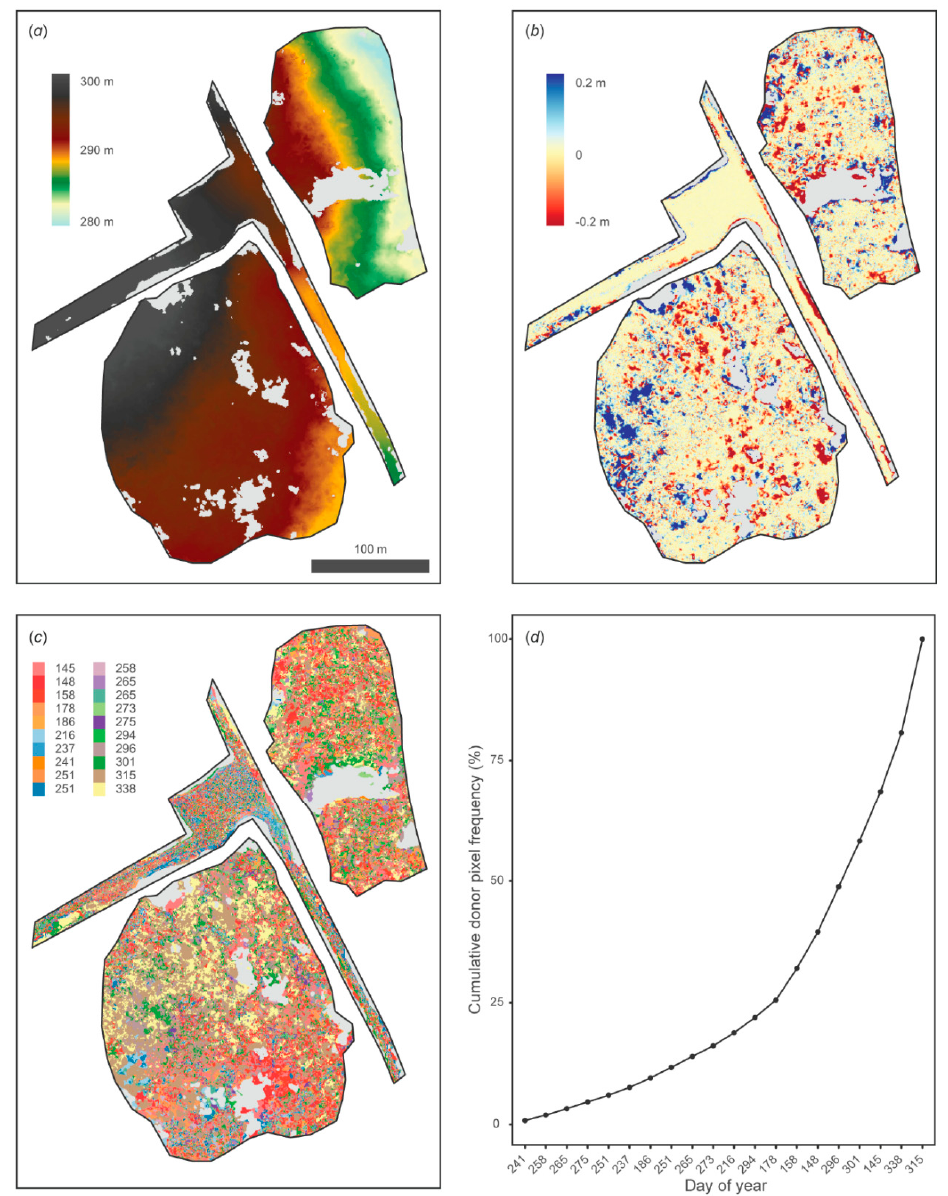
Figure 6. Results of the best available terrain pixel (BATP) analysis including ( a ) the BATP DTM ( b ), composite error map, ( c ) donor pixel map, and ( d ) cumulative donor pixel frequency chart indicating the days of year with the least to highest frequency of donated pixels for the BATP DTM. Light grey colour indicates the full extent of the reference DTM.